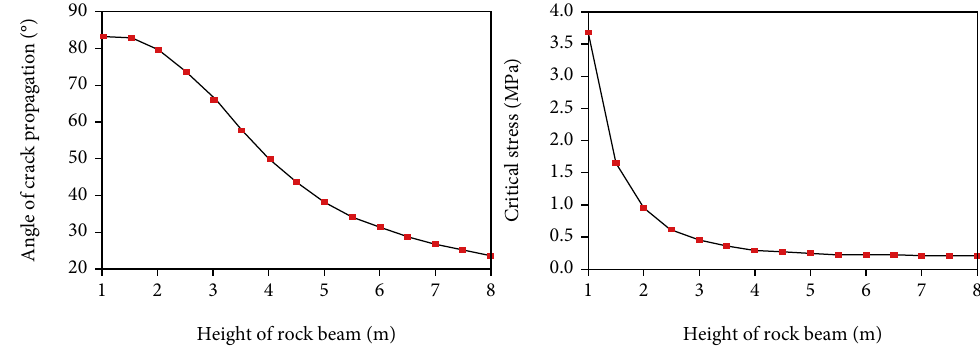
Figure 10: Sensitivity analysis of crack propagation angle and critical stress and rock beam